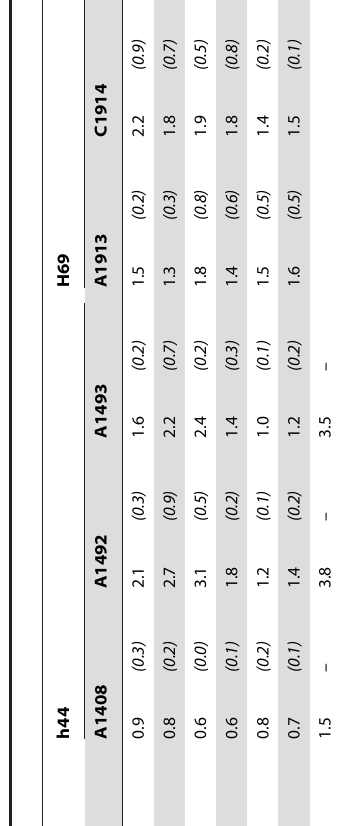
Table S3 in File S1): for every ribosomal variant that was simulated, the presence of PAR bound at the A-site was found to distinctly weaken this H-bond. In contrast, we observed the opposite effect — an increase in H-bond stability — in both of the hyper-accurate mutants that we examined (K42A and R53A), compared to the wild-type equivalent. Therefore, we suspect the stability of the h44 ??? h27 ??? S12 interaction network might be connected to the decoding